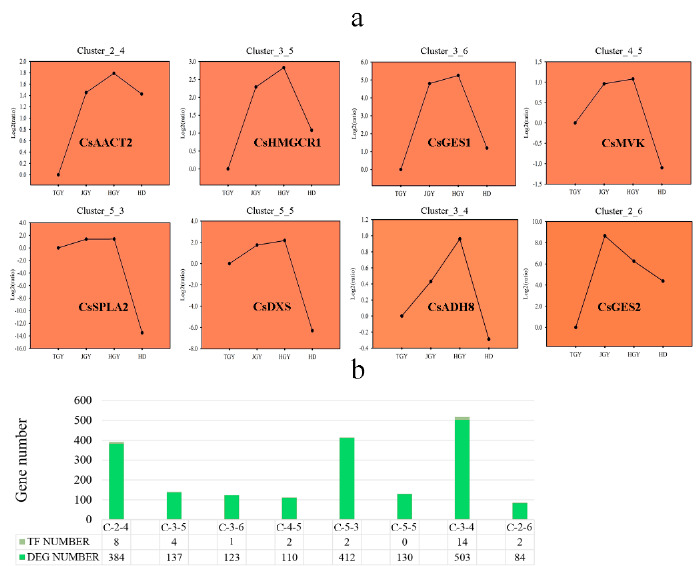
Figure 6. Eight genes involved in volatile biosynthesis were analyzed by SOM (Self-Organizing Feature Map) cluster analysis with R package kohonen. ( a ) Line chart of different expression patterns cluster analysis. ( b ) Number of genes and TFs in different expression patterns. Molecules 2019 , 24 , x FOR PEER REVIEW